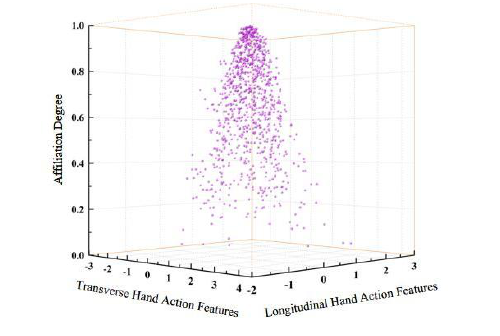
Figure 15. Cloud model generated by motion features at a certain